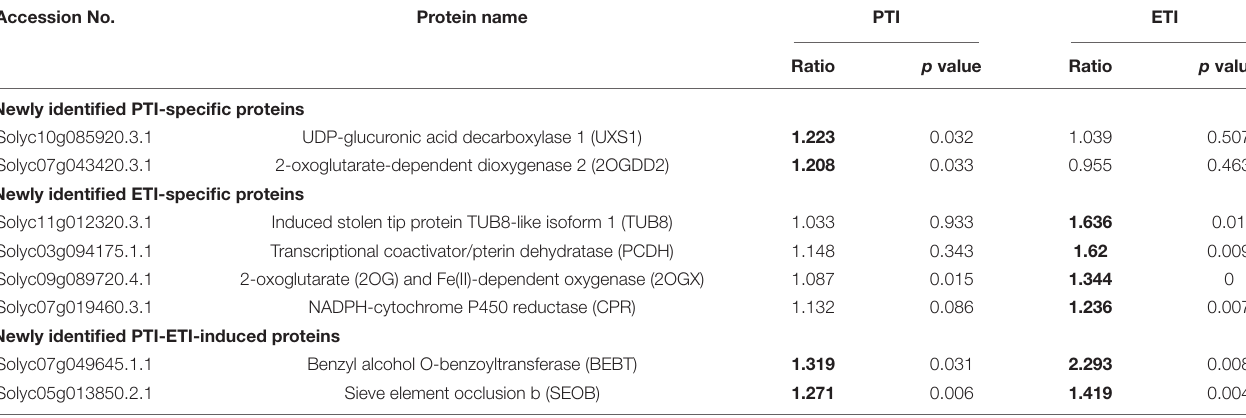
TABLE 1 | Putative newly identified PTI-specific, ETI-specific, as well as common ETI and PTI-induced proteins. Accession